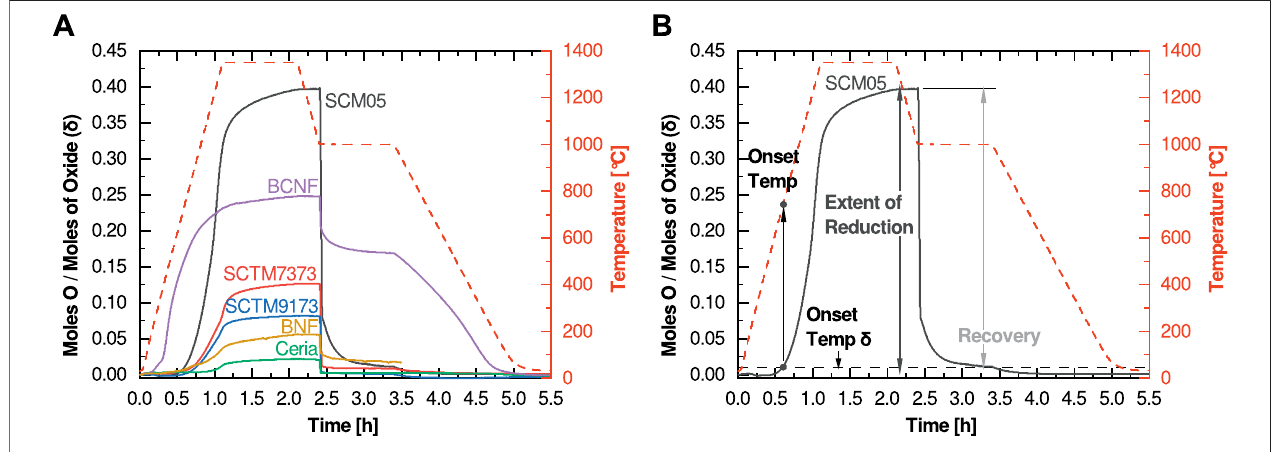
FIGURE 1 | (A) TPTR results for the six compositions of interest. (B) Visual descriptions of the three fi gures of merit for